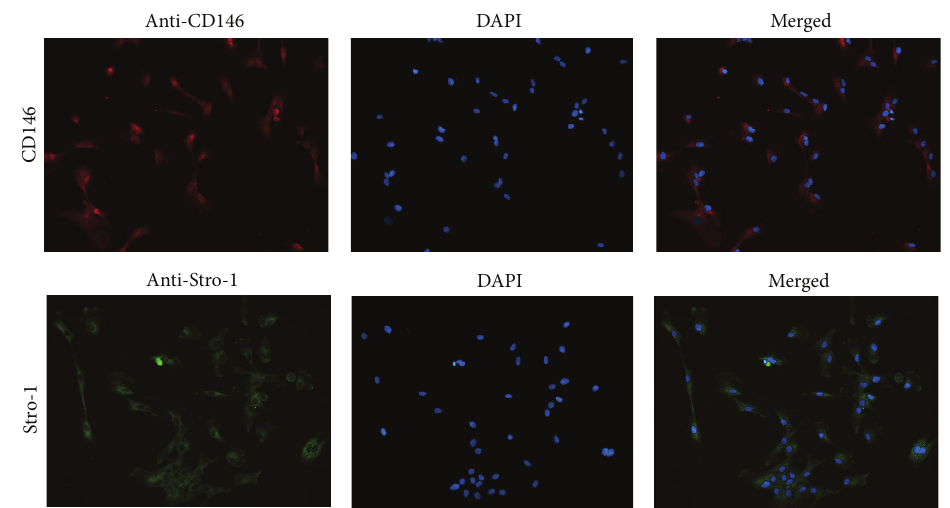
Figure 3: Immunofluorescence staining of CD146 and Stro-1 on